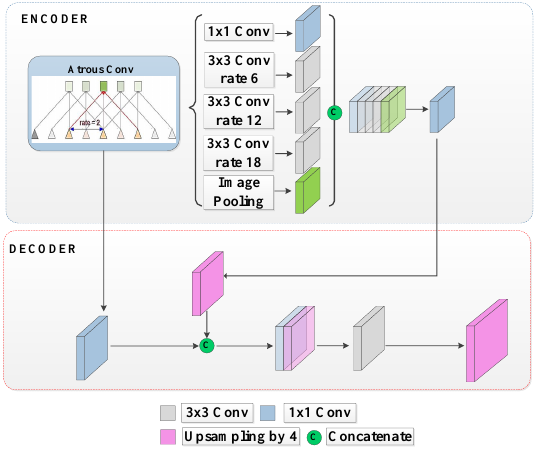
Figure 3. DeepLabv3+ Arquitecture adapted from (Chen et al.,